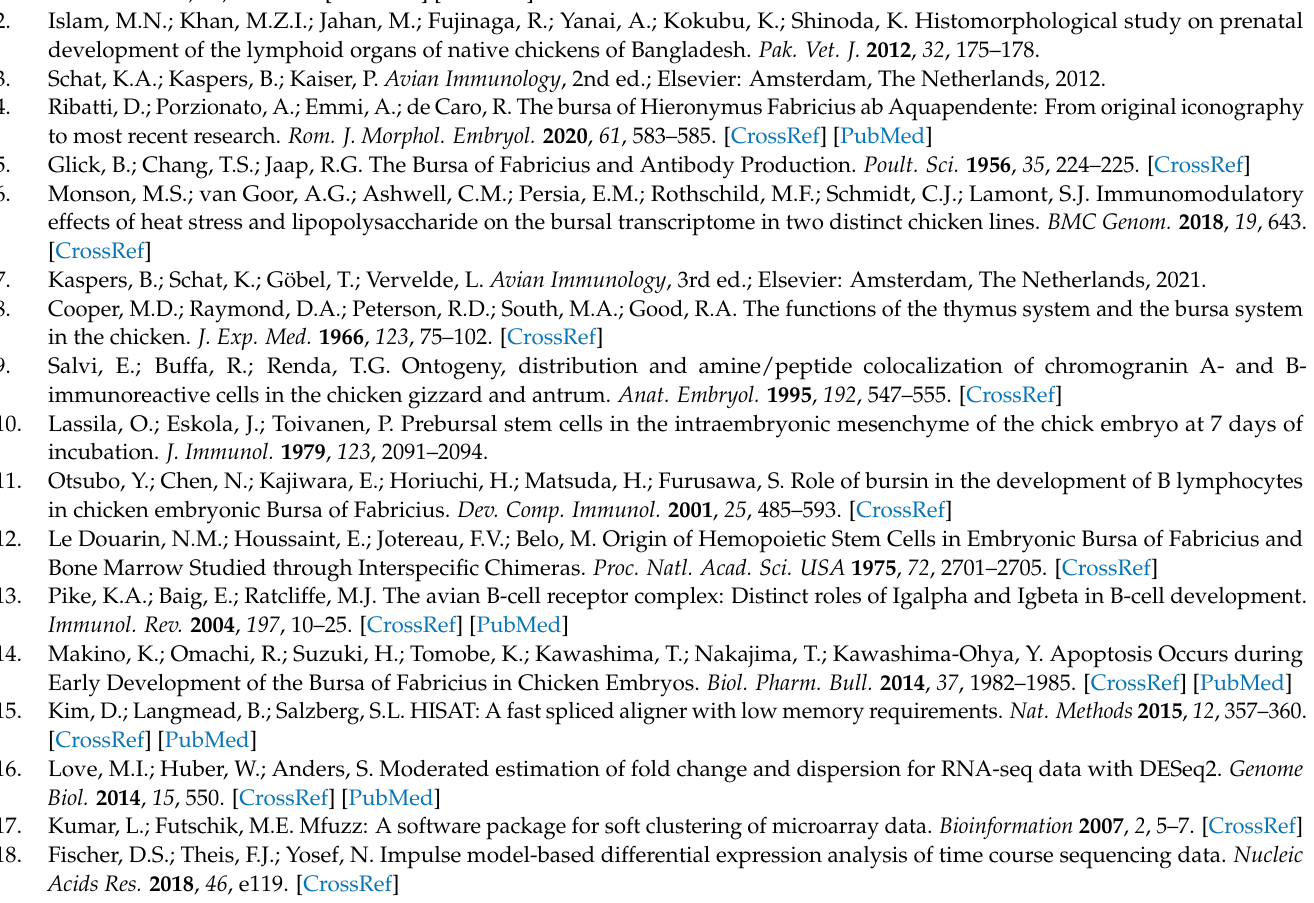
Table S2: The list of primers used in the present study; Table S3: All DEG expression changes in each comparison group; Table S4: The list of DEGs enriched by KEGG; Table S5: The list of DEGs enriched by GO; Table S6: The list of DEGs enriched by